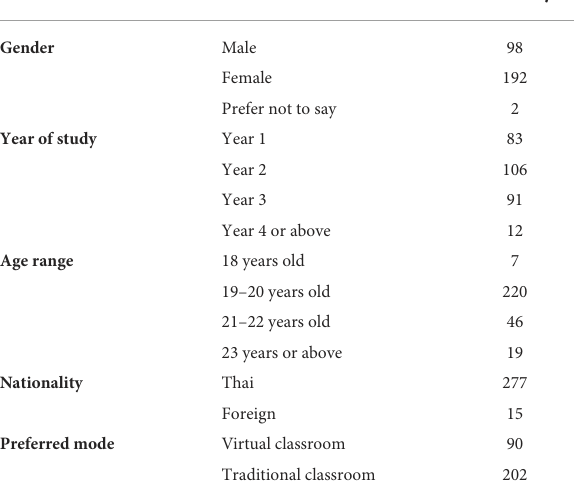
TABLE 3 Sample from Mae Fah Luang University in Chiang Rai, Thailand. Characteristics